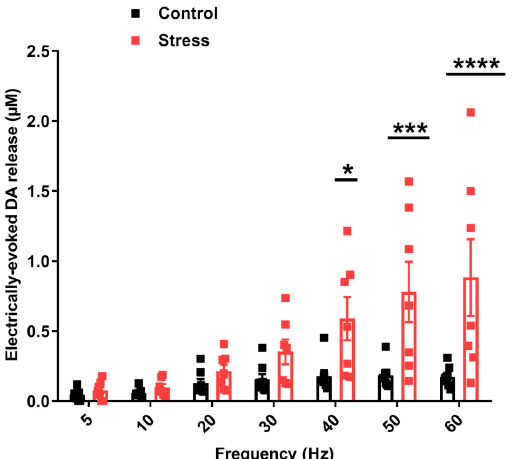
Figure 5. Electrically evoked dopamine is released in a frequency-dependent manner 24 h after social defeat stress exposure. Dopamine efflux in the NAc of defeated (n = 7) and control (n = 8) rats was recorded following VTA electrical stimulation (1 s, 5–60 Hz, 5–60 pulses, current 330 µ A). Stimulations were taken every 10 min. Data are presented as mean ± SEM, repeated measures two-way ANOVA; * p < 0.05; *** p 0.001; **** p <